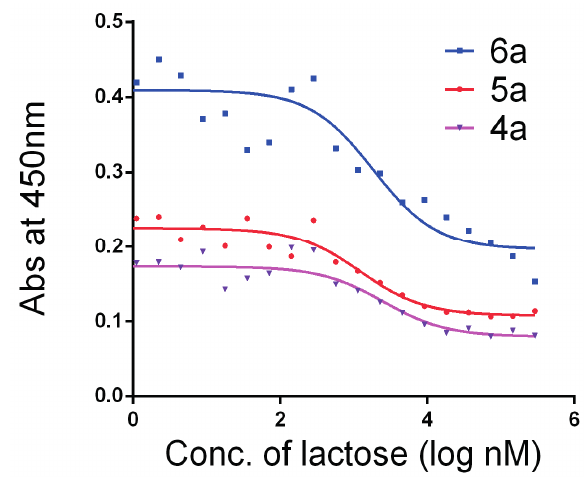
Figure 8. ELISA binding curve with 4a , 5a , and 6a .